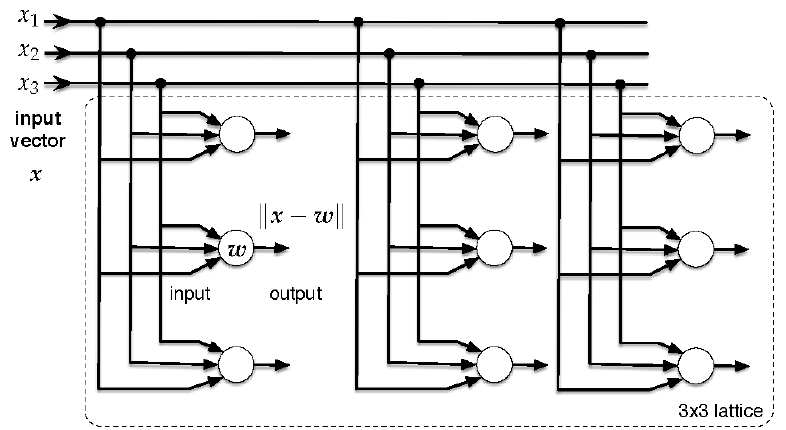
Figure 5. Flow diagram of the SOM training